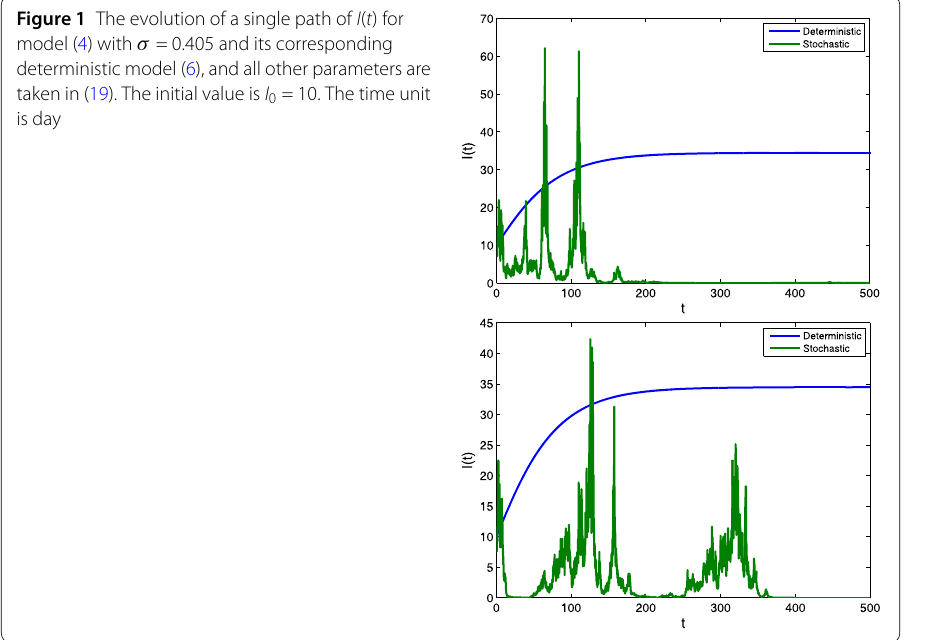
Figure 1 The evolution of a single path of I ( t ) for model (4) with σ = 0.405 and its corresponding deterministic model (6), and all other parameters are taken in (19). The initial value is I 0 = 10. The time